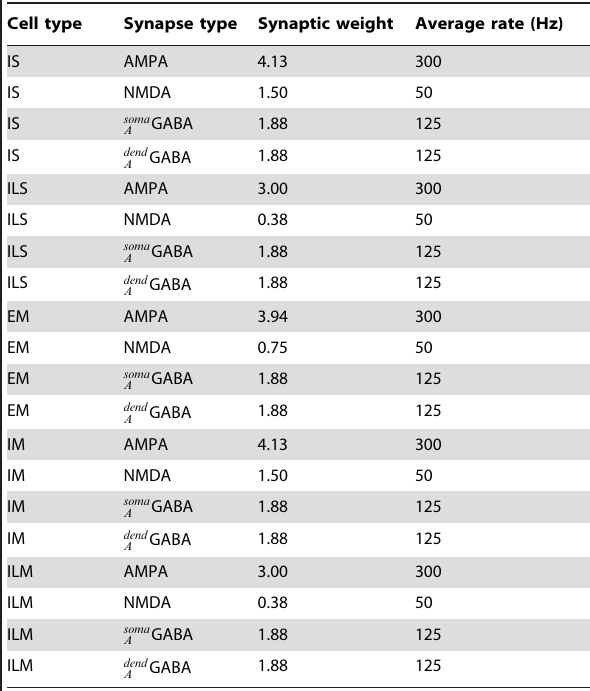
Table 3. Noise stimulation to synapses of the different cell types.